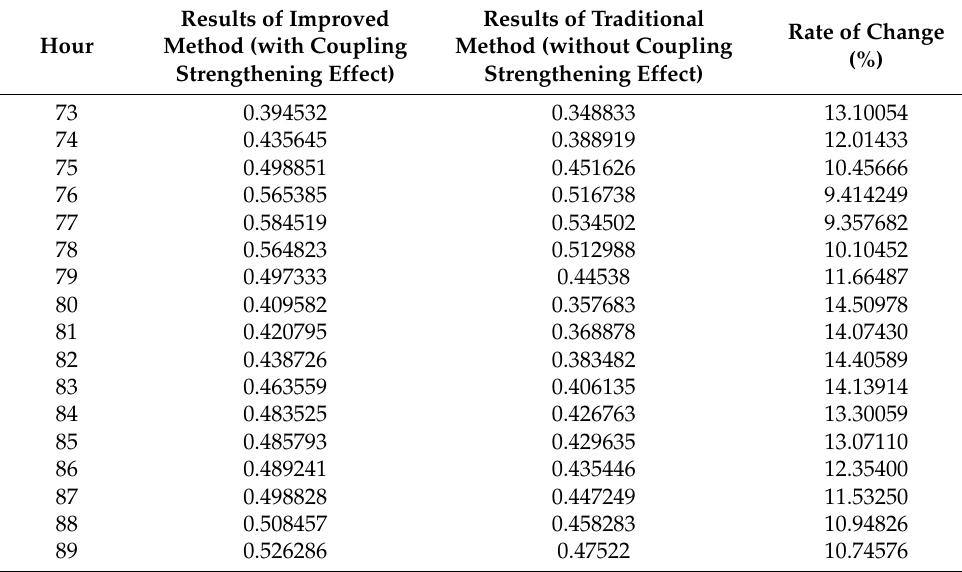
Table 3. Results of the assessment with and without the coupled strengthening